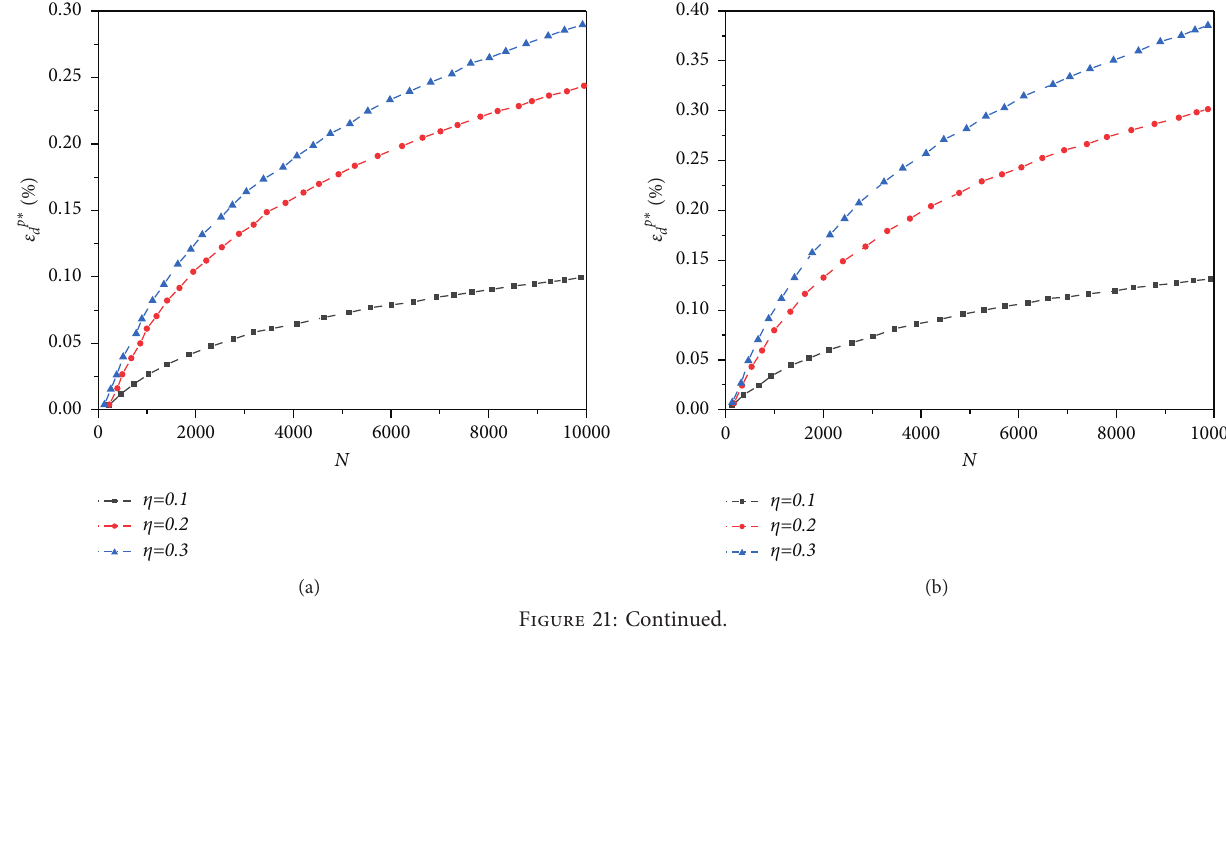
Figure 20: Influence of frequency on the relationship between cumulative plastic strain and number of vibrations. (a) q (b) q d � 20kPa, and (c) q d �